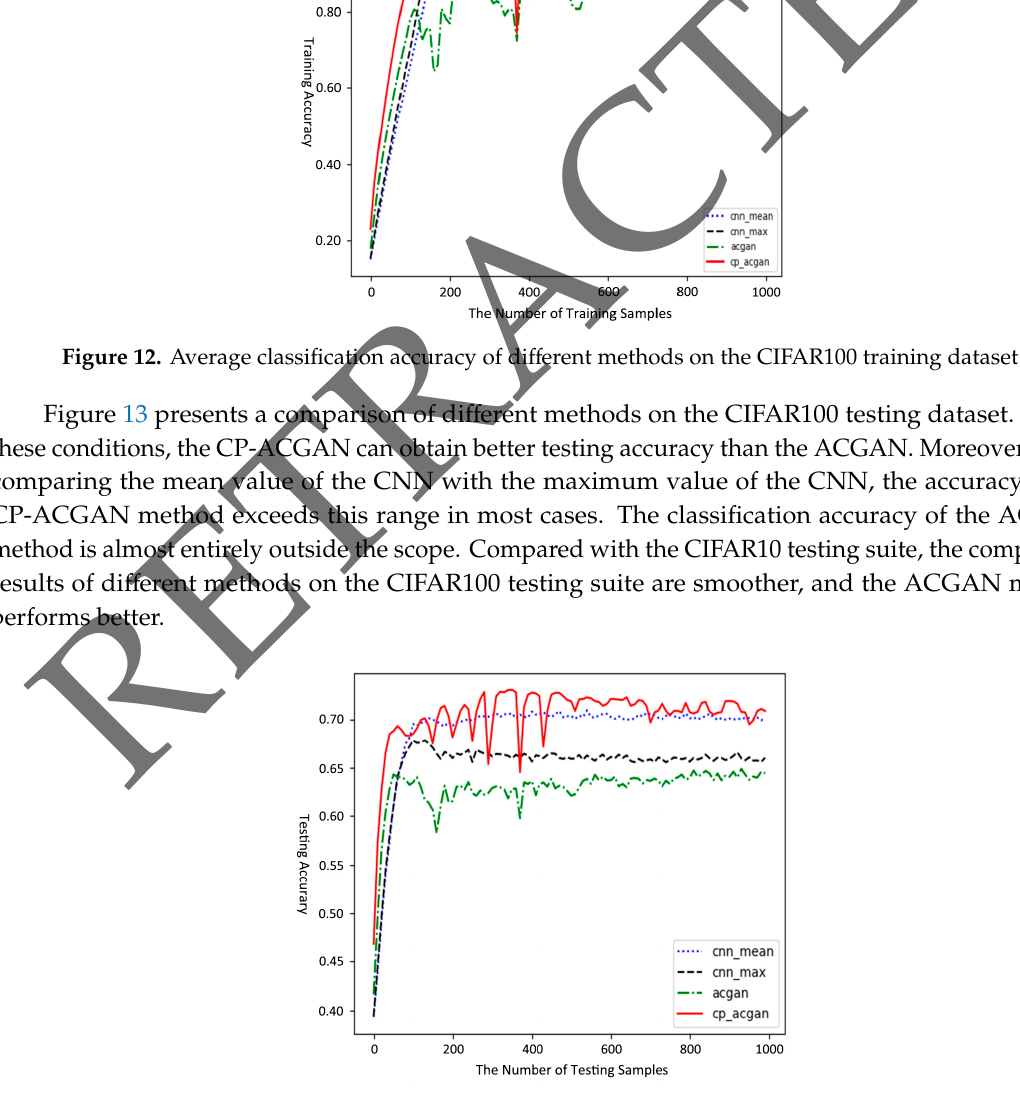
Figure 13. Average testing accuracy comparison on the CIFAR100 testing dataset.